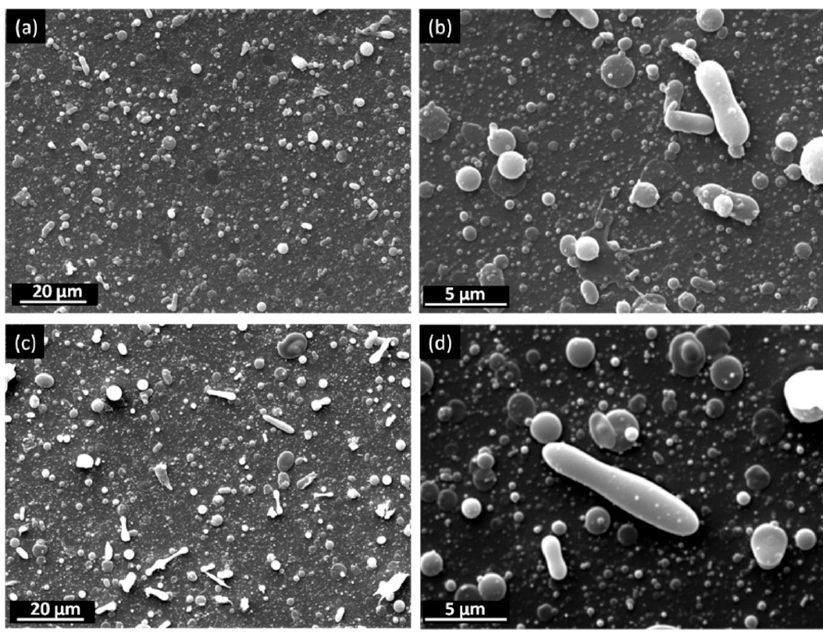
Figure 3. SEM images of ( a , b ) 13-93 and ( c , d ) 13-93-B3 BG coated Ti, registered at two different magnifications.